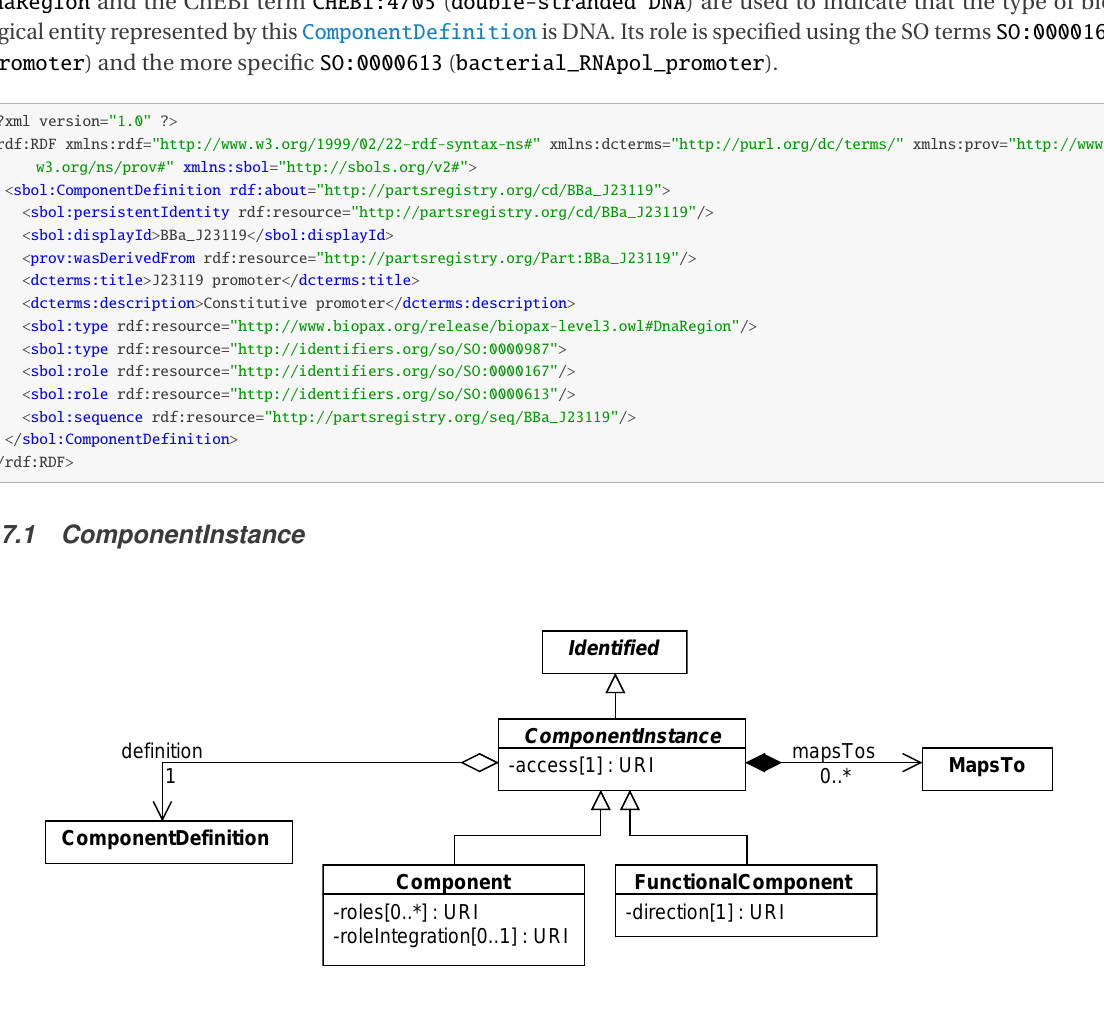
Figure 8: Diagram of the ComponentInstance class and its associated